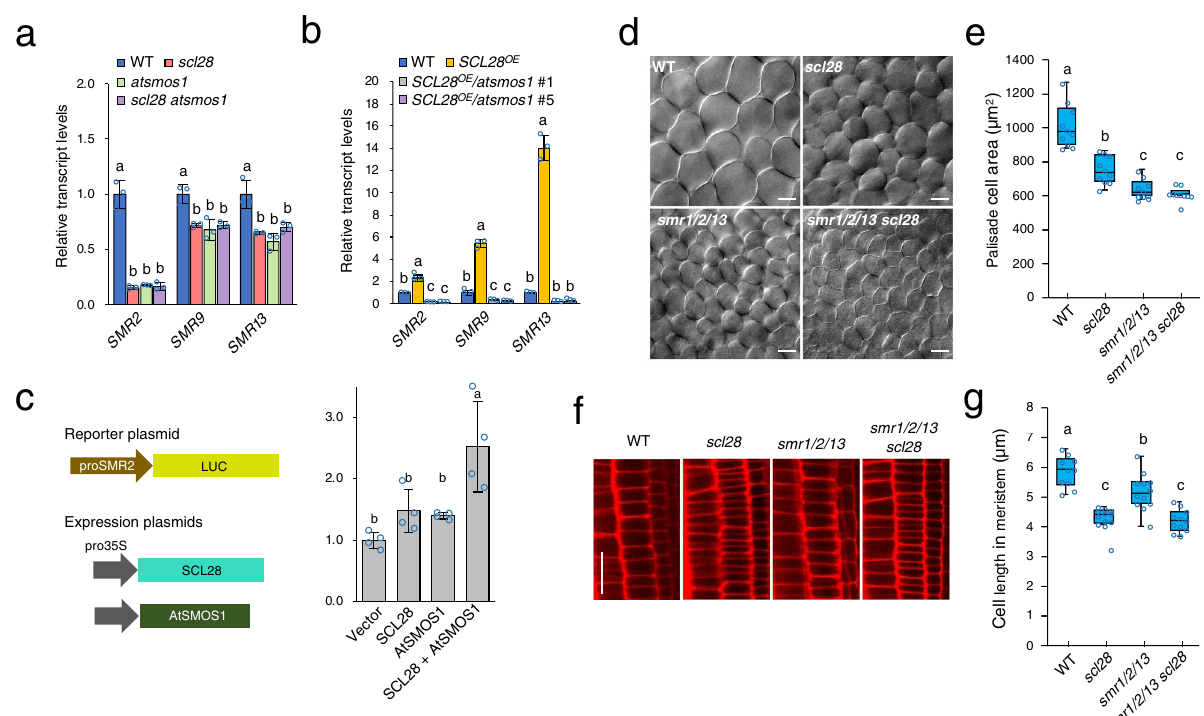
Fig. 7 Cell size control by SCL28-AtSMOS1 is mediated by SMR s. a Double scl28 atsmos1 mutation downregulates SMR genes, equivalently to each single mutation. qRT-PCR analysis of SMR2, SMR9 and SMR13 transcripts was performed for comparing expression levels in WT, scl28 , atsmos1 , and scl28 atsmos1 plants. Data are shown as averages from three biological replicates (±SD). Statistical analysis was performed for each SMR gene based on one-way ANOVA and Tukey ’ s test, and signi fi cant differences ( P < 0.05) were shown in different letters above the bars. b Upregulation of SMR genes in SCL28 OE requires presence of AtSMOS1. qRT-PCR analysis was performed for comparing expression levels between atsmos1 , SCL28 OE plants, and those carrying atsmos1 and SCL28 OE in combination. Two independent lines were used for analyzing SCL28 OE / atsmos1 . Data are shown as averages from three biological replicates (±SD). Statistical analysis was performed as in ( a ). c Co-expression of SCL28 and AtSMOS1 activates the SMR2 promoter in the protoplast transient assay. proSMR2::LUC reporter plasmid was transfected into protoplasts prepared from T87 cells together with expression plasmids of SCL28 and AtSMOS1 as indicated. Schematic presentation of reporter and expression plasmids as shown on the left. Data are shown as averages from four biological replicates (± SD). Statistical analysis was performed as in ( a ). d DIC observations of leaf palisade cells in WT, scl28 , smr1/2/13 , and smr1/2/13 scl28 plants at 22 DAS. Scale bar indicates 20 µ m. e Quanti fi cation of palisade cell area in the fi rst leaf pairs from plants with indicated genotypes. Boxplot was generated using data collected from leaves of ten different plants, in each of which more than 60 cells were analyzed (midline = median, box = IQR, whiskers = 1.5 × IQR). Different letters above the boxplots indicate signi fi cant differences ( P < 0.05) based on one-way ANOVA and Tukey ’ s test. f CLSM observation of cortical cell fi les in root meristems from WT, scl28 , smr1/2/3 , and smr1/2/13 scl28 plants at 7 DAS. Scale bar indicates 20 µ m. g Quanti fi cation of cortical cell length in root meristems from plants with indicated genotypes. Boxplot was generated using data collected from roots of multiple individual plants (midline = median, box = IQR, whiskers = 1.5 × IQR). Numbers of plants analyzed were 10, 12, 12, and 11 for WT, scl28 , smr1/2/3 , and smr1/2/13 scl28 , respectively. In each plant, more than 40 cells were analyzed for calculating average, which were further used for statistical analysis. Different letters above boxplots indicate signi fi cant differences as in ( e